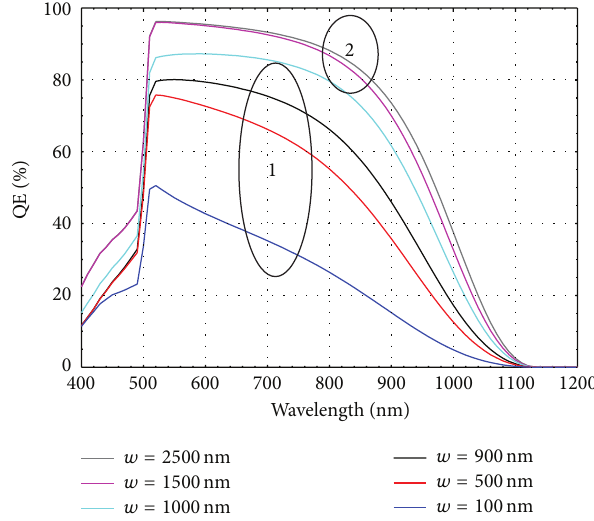
Figure 4: Quantum efficiency of the cell as a function of incident light wavelength for the two zones of the absorber thickness. 1 and 2 denote, respectively, the first zone and second